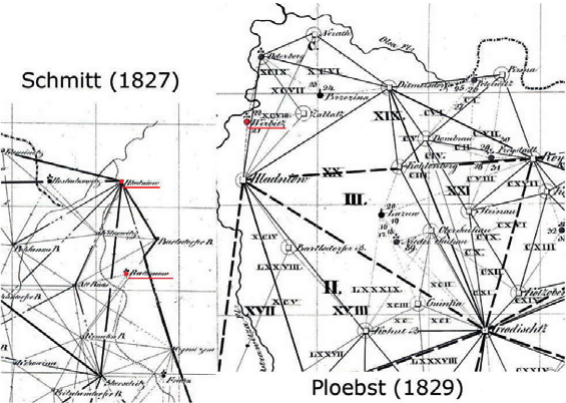
Fig. 4. Division of the Ostrava area into two parts for purposes of triangulation works in the stable cadastre